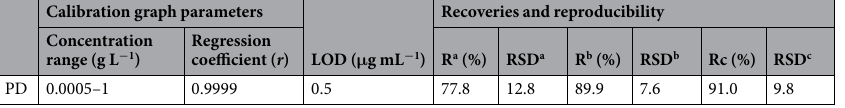
Table 3. Calibration Graph Parameters, Limits of Detection (LOD), Recoveries (R) and Reproducibility (RSD, n = 3) were Calculated from Extractions with Three FGFR4/CMCSPs Columns from Different Batches. a